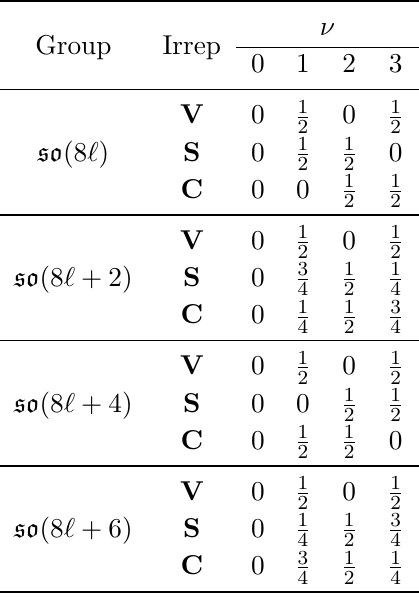
Table 6. Fractional parts of the allowed u (1) charges for various representations of so (2 n ) . V refers to the vector representation with highest weight [1 , 0 , . . . , 0] . S refers to the spinor represen- tation with highest weight [0 , . . . , 0 , 1] . C refers to the spinor representation with highest weight [0 , . . . , 1 , 0]